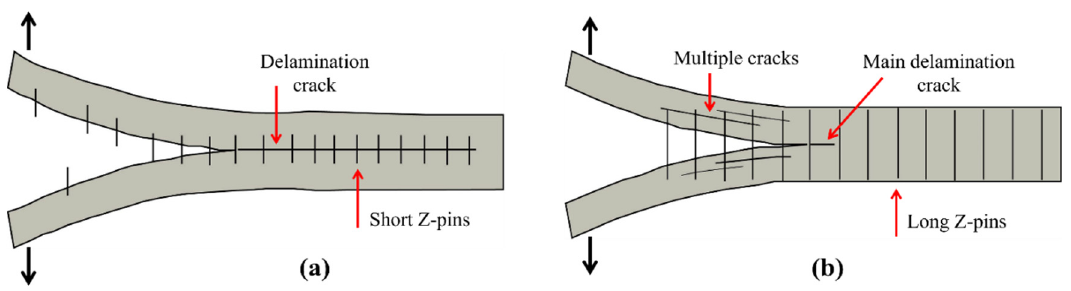
Figure 25. Schematic presentation of mode I fatigue delamination behaviour of composite with z-pins ( a ) short z-pins ( b ) long z-pins.